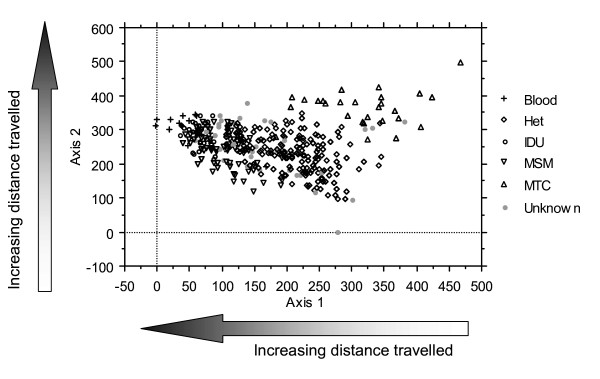
Detrended correspondence analysis (DCA) bi-plot to visualise the relationships between demographic and infection variables (listed in table 1). Axes 1 and 2 are the major axes of variation between individuals based on the inclusion of all measured variables (such that those at opposite ends of an axis are the most different, hence those that are most similar can form identifiable groupings). Arrows along the axes illustrate the significant correlation between distance travelled and the axis score (Axis 1: Spearman's rs = -0.135, P < 0.001; Axis 2: Spearman's rs = 0.274, P < 0.001). The individuals are labelled by infection route (Blood = contaminated blood/blood products, Het = heterosexual, IDU = injecting drug use, MSM = men who have sex with men, MTC = mother to child).